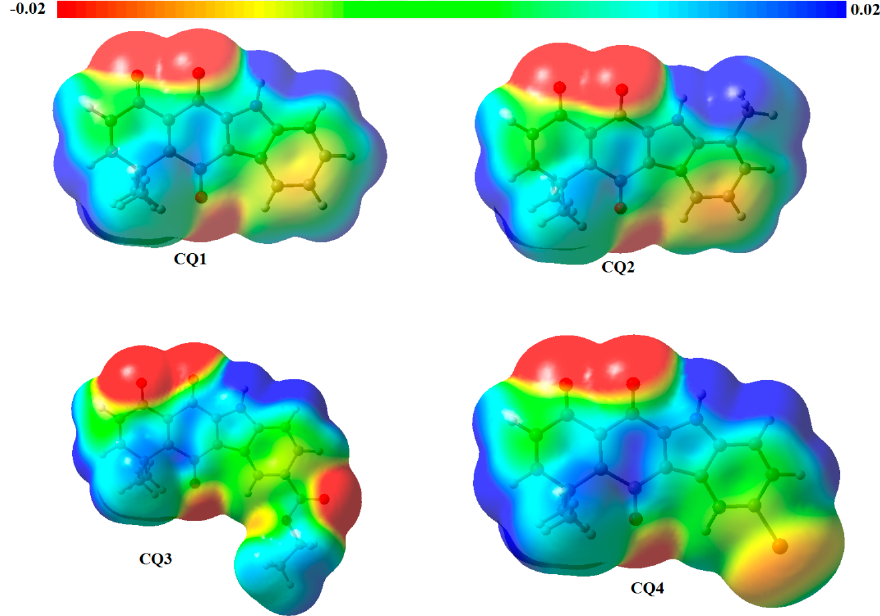
Figure 3. Molecular electrostatic potential maps (MEP) for o -carbonylcarbazolequinones CQ1 to CQ4 . Red color indicates high electron density and blue color low electron density. Table 1. Fukui function ( f − ) and Parr function ( P − ) for electrophilic attack. Fukui Function for Electrophilic Attack Parr Function for Electrophilic Atom